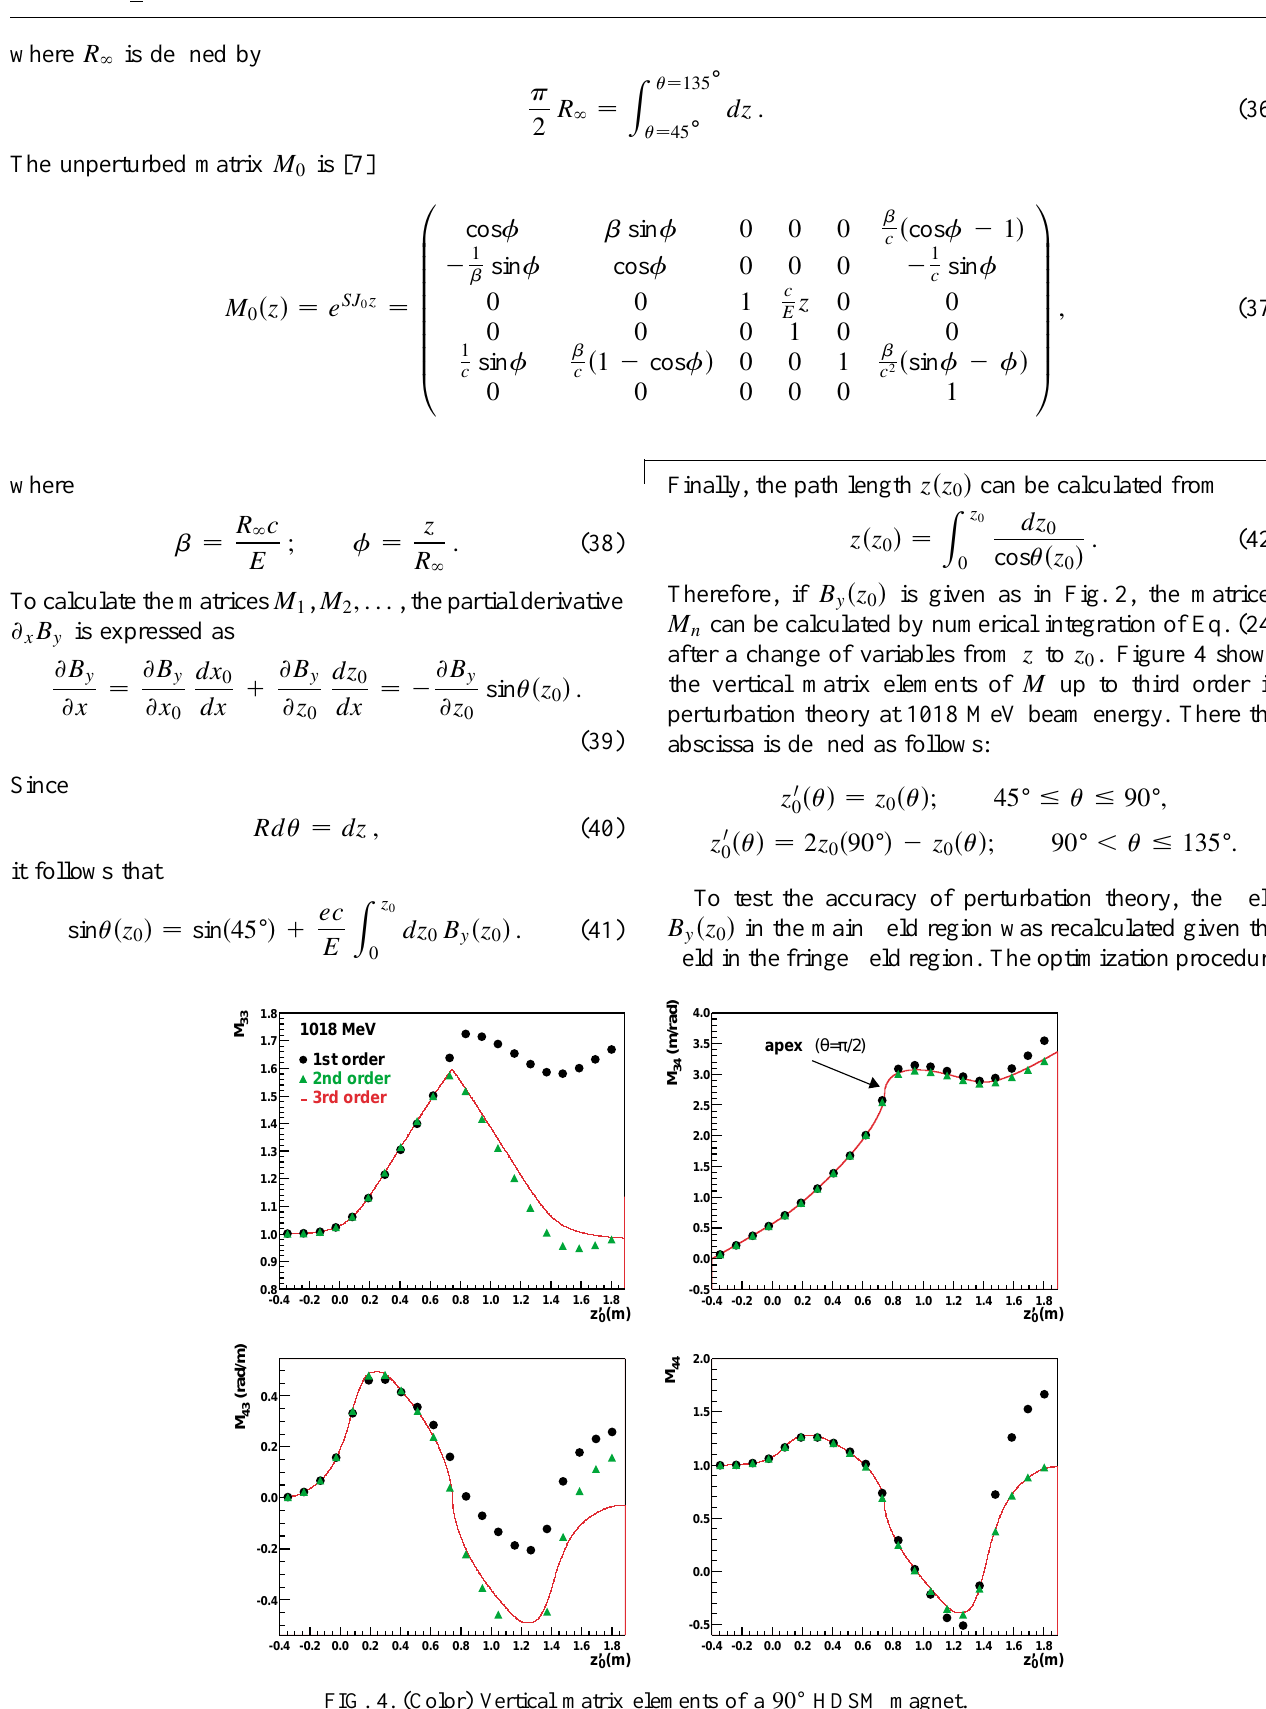
FIG. 4. (Color) Vertical matrix elements of a 90 ± HDSM